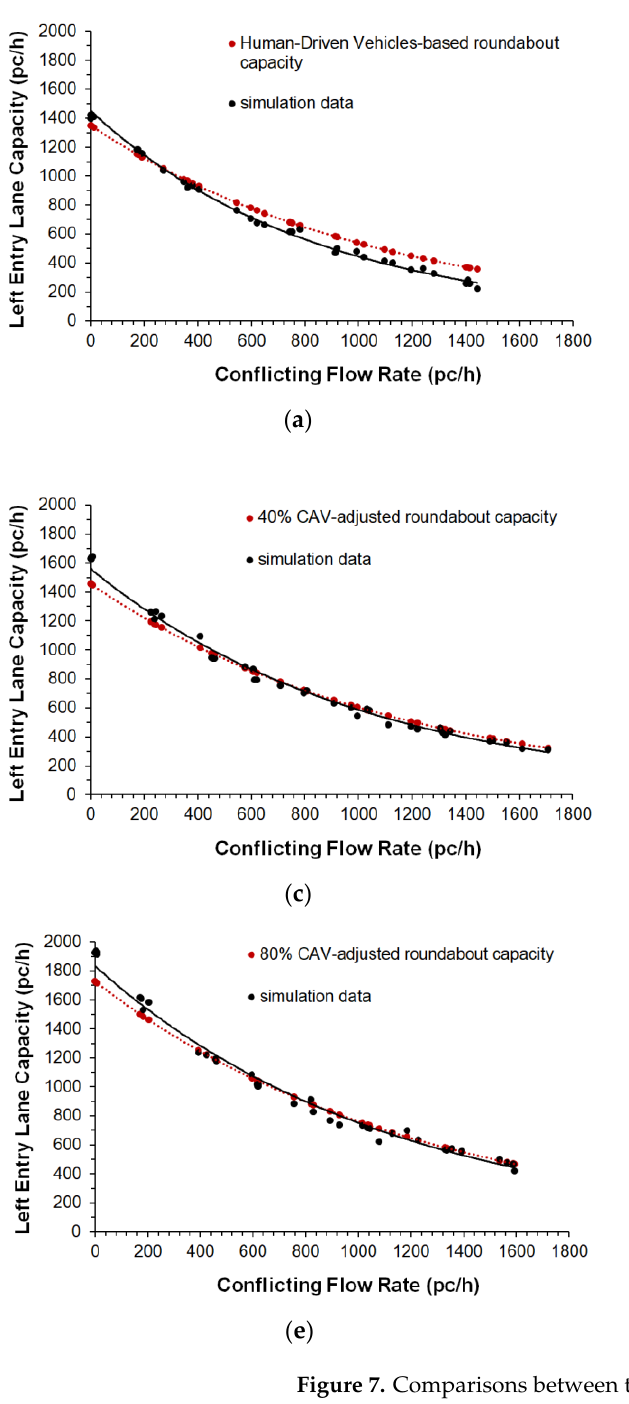
( f ) Figure 6. Scattergram analysis to compare the CAV-adjusted and simulated entry capacity data for different proportion of CAVs and HDVs for the entry mechanism 1 (i.e., one-lane entry conflicted by one circulating lane) listed as: ( a ) baseline scenario: 0% CAVs and 100% HDVs; ( b ) scenario 1: 20% CAVs and 80% HDVs; ( c ) scenario 2: 40% CAVs and 60% HVs; ( d ) scenario 3: 60% CAVs and